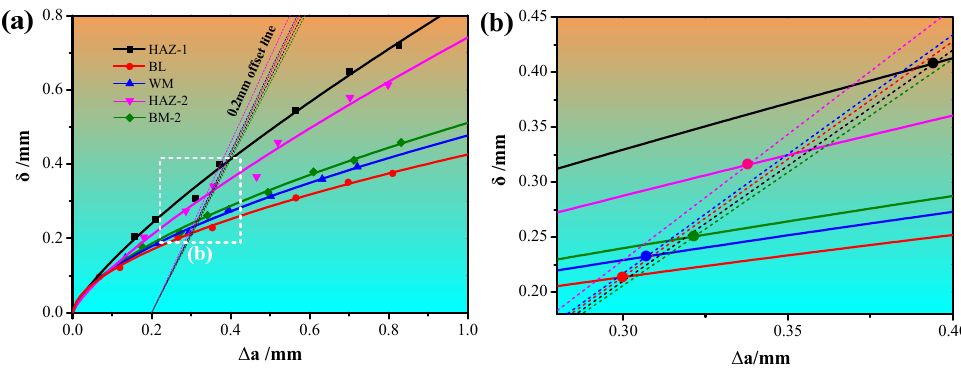
Figure 4. δ -R curves of five regions ( a ) and local enlarged image ( b ).